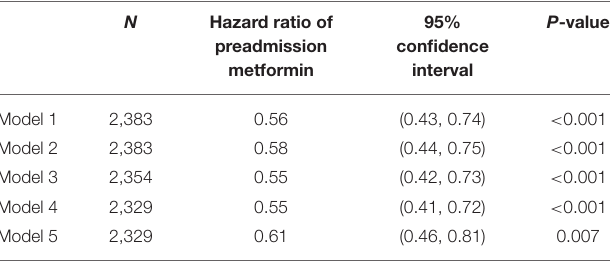
TABLE 2 | Association between preadmission metformin use and 30-day mortality using an extended model approach.